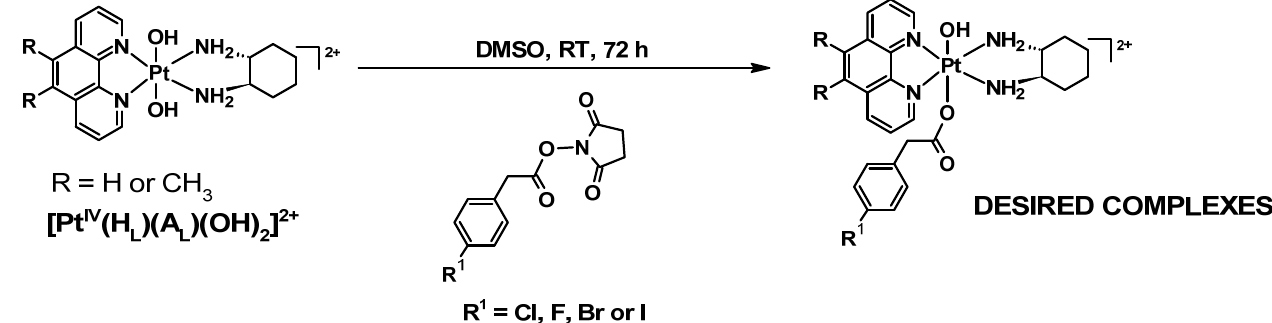
Figure 8. Synthesis route to achieve the desired platinum(IV) complexes incorporating the halogenated PAA derivatives, 4-CPA, 4-FPA, 4-BPA, and 4-IPA. Table 1. A summary of experimental yields (%), HPLC peak areas (%), T R (min), and mass-to-charge ratios ( m / z ) of the studied complexes.